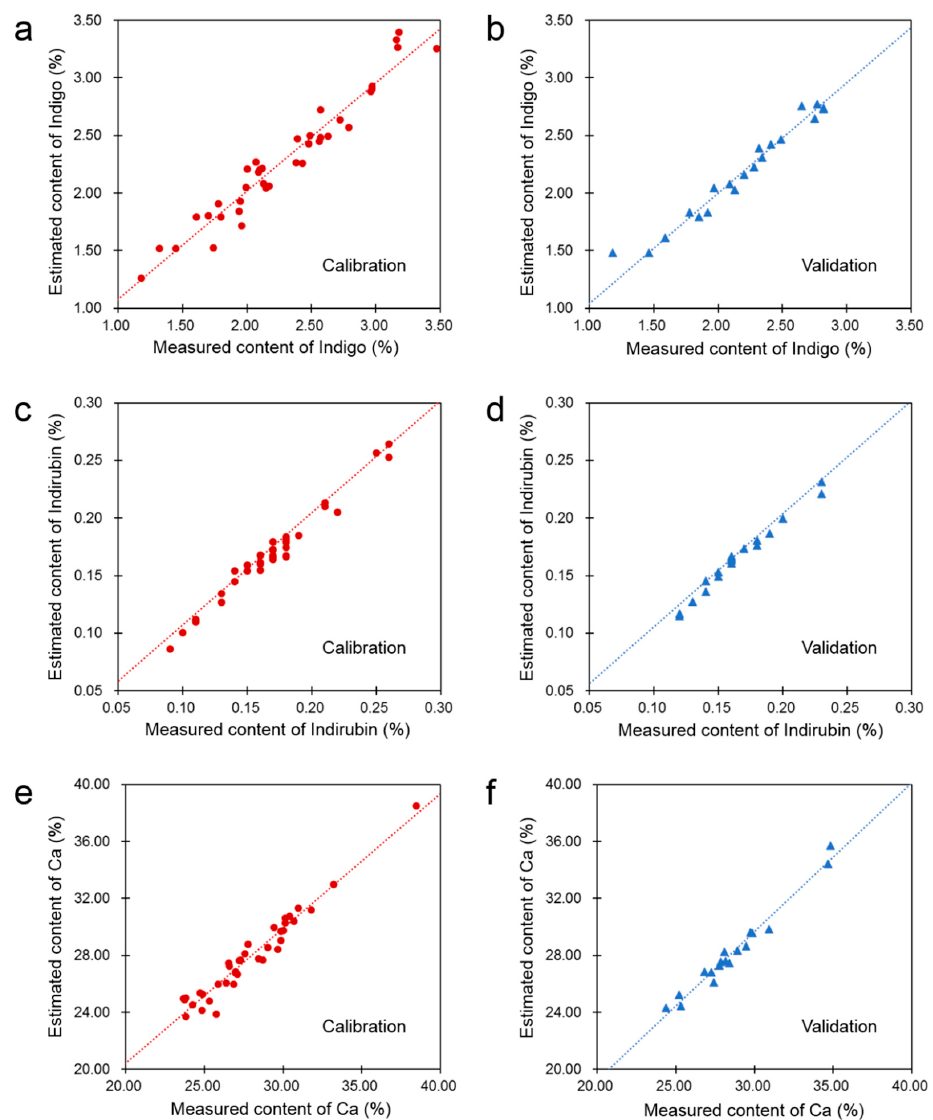
Figure 4. Comparisons between the ATR-FTIR model estimated and the reference method measured